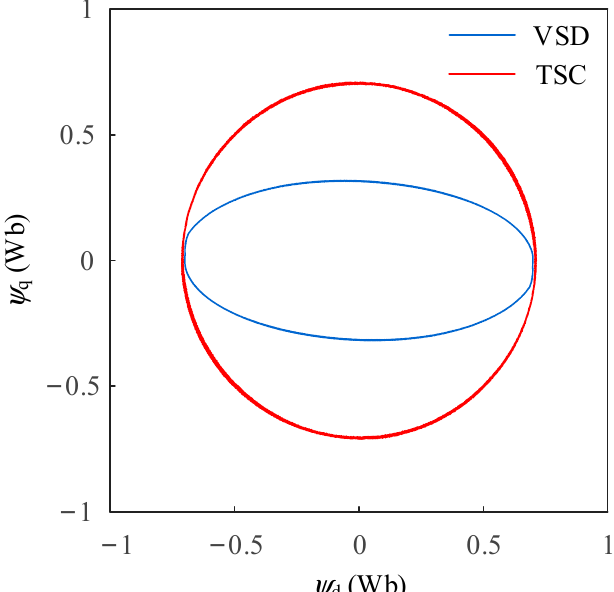
Figure 8. Flux linkage trajectory in the d-q subplane for the non-fault-tolerant decoupling control and the TSC control.